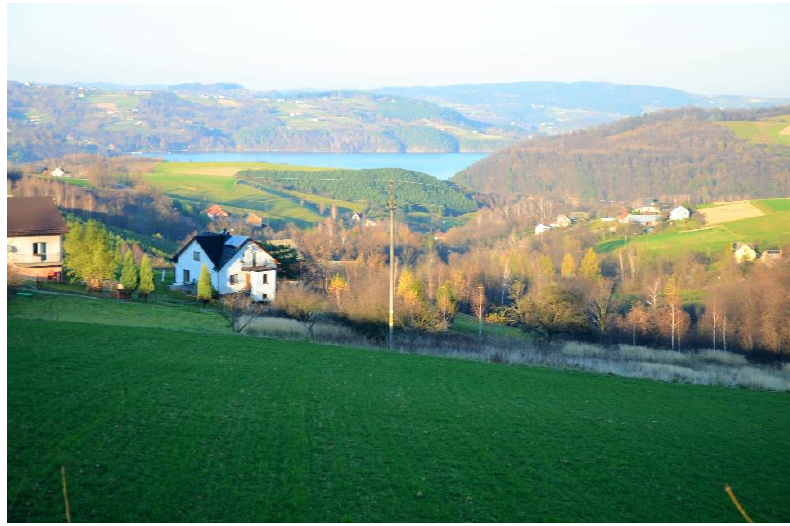
Figure 2. Perspective view of the study area, captured during the field investigation.